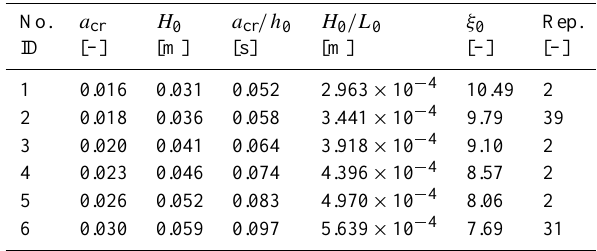
Table 1. List of sinusoidal waves used, values refer to measure- ments at the wavemaker, water depth h = is 0.31m, period T is 60s, linear wave length L 0 becomes 104.63m, ξ 0 surf similarity, no. of repetitions is given under